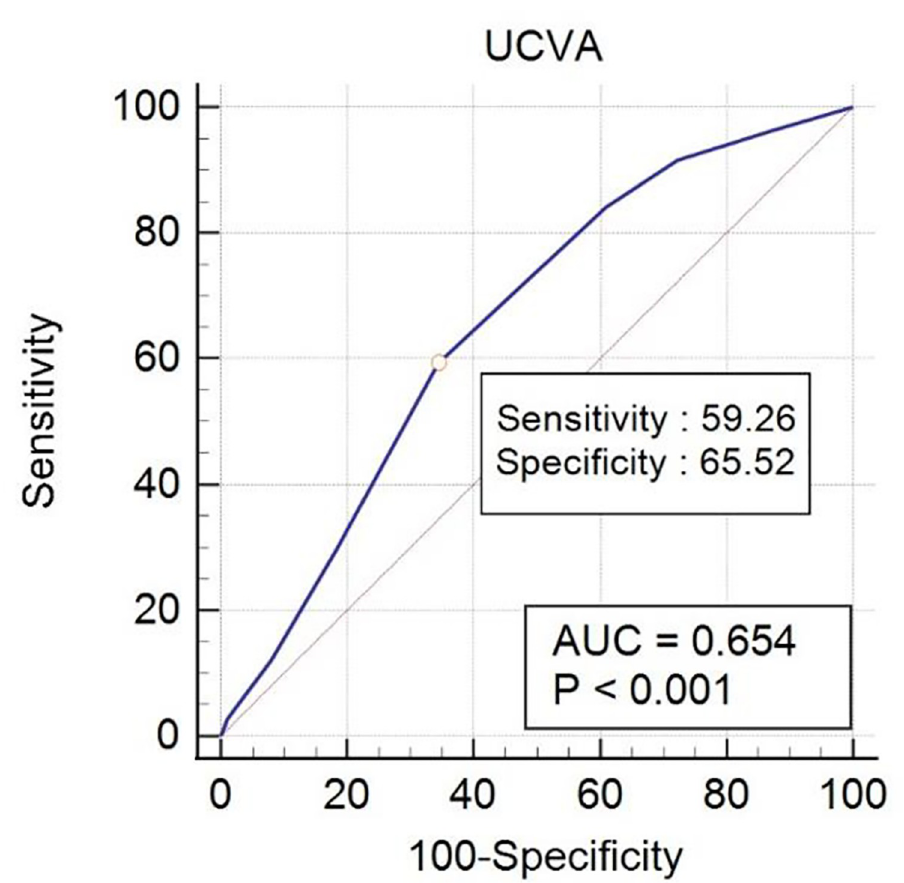
Fig 1. Receiver operating characteristic (ROC) curve analysis revealing the relationship between distance uncorrected visual acuity (UCVA) and the Worth 4-dot (W4d) test. ROC curve analysis identified a UCVA value of 0.3 logMAR (20/40 in Snellen acuity) or better as the optimal cut-point value of visual acuity required for interpreting the results of the W4d test (ROC area under the curve: 0.654; 95% CI: 0.582 − 0.720; p < 0.001). A UCVA value of 0.3 logMAR (20/40 in Snellen acuity) or better yielded a sensitivity of 59.26% and a specificity of 65.52%.